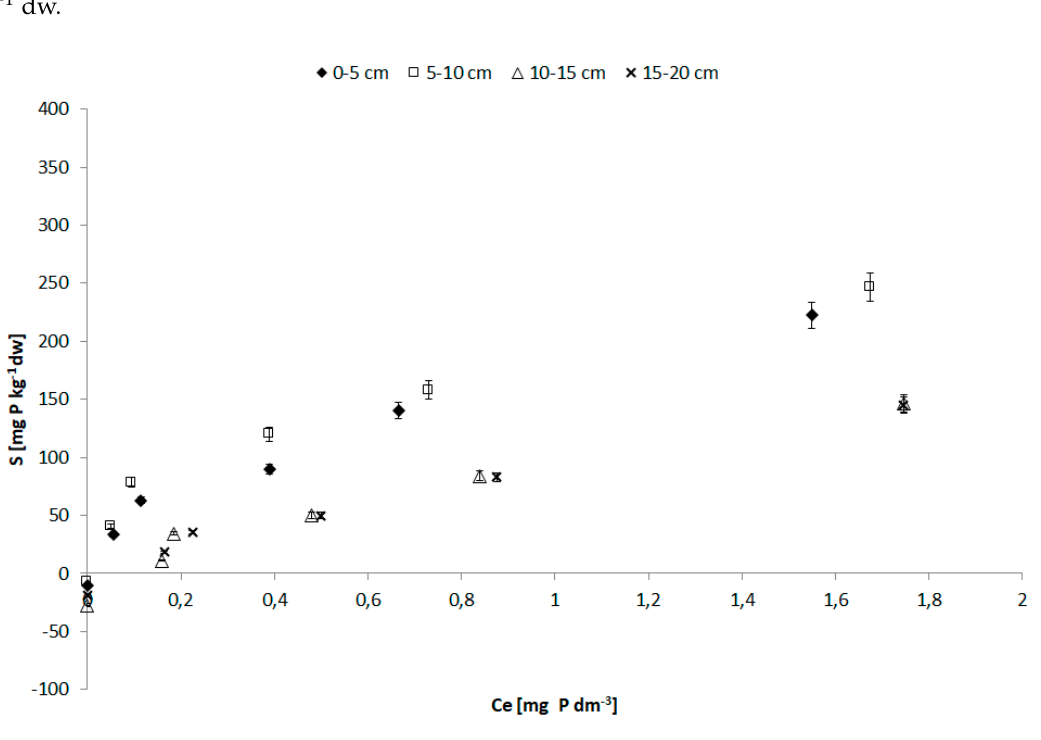
Figure 3. The P adsorption isotherms for sediment taken at St. 2.